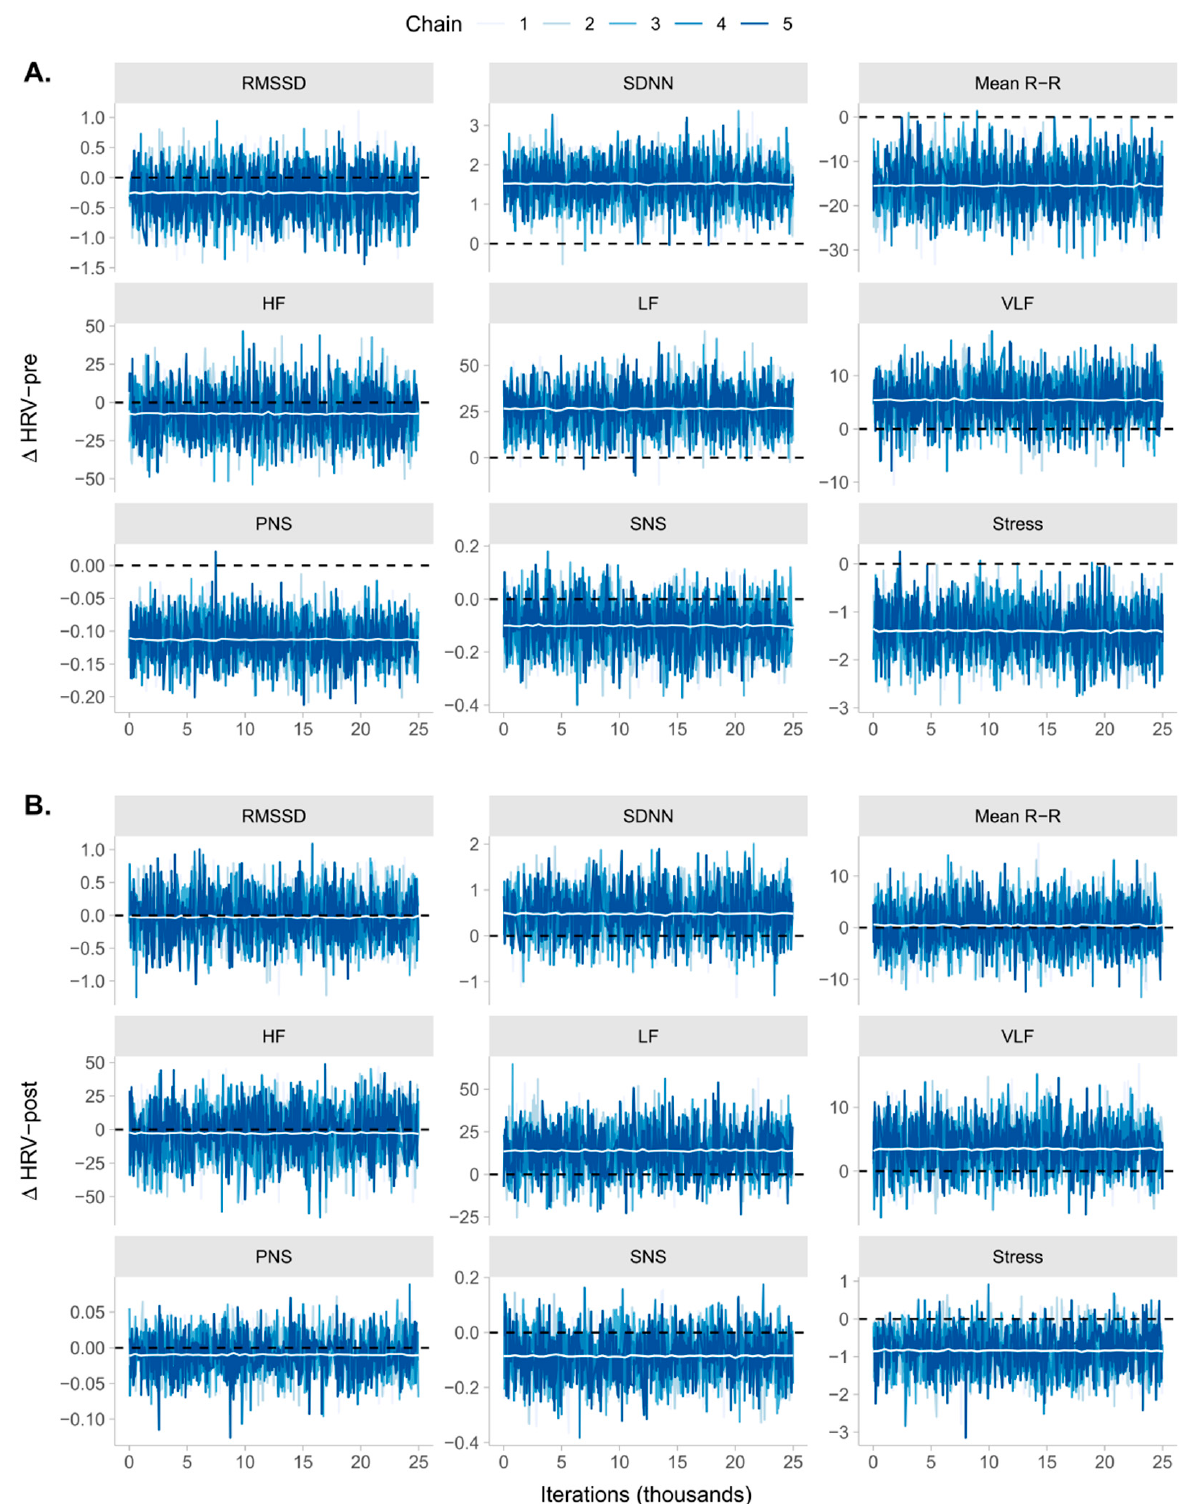
Figure 2. Trace plots indicating the estimated values for ∆ HRV-TMST [2-1] on each iteration (horizontal axis) for each MCMC chain. The white line at the center of each trace plot represents the median value from all chains in 500-iteration intervals. ( A ) Model diagnostics for HRV parameters pre-TMST; ( B ) model diagnostics for HRV parameters post-TMST.